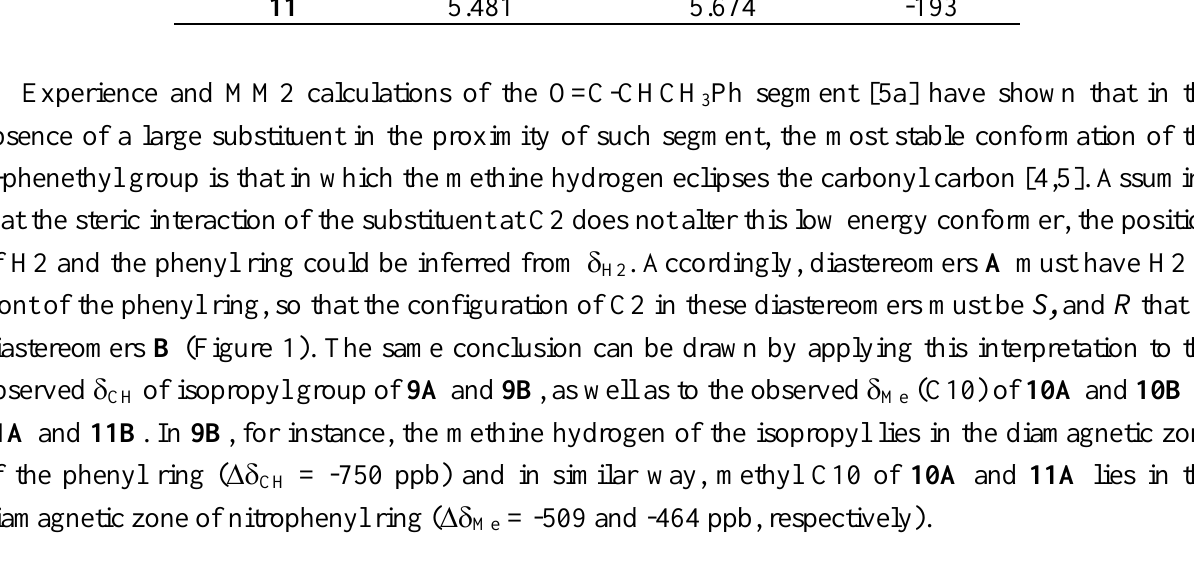
Table 1 . δ Values of dihydroquinazolinones 8 - 11 , obtained from 400 H2 MHz spectra of 0.5 M solutions in CDCl